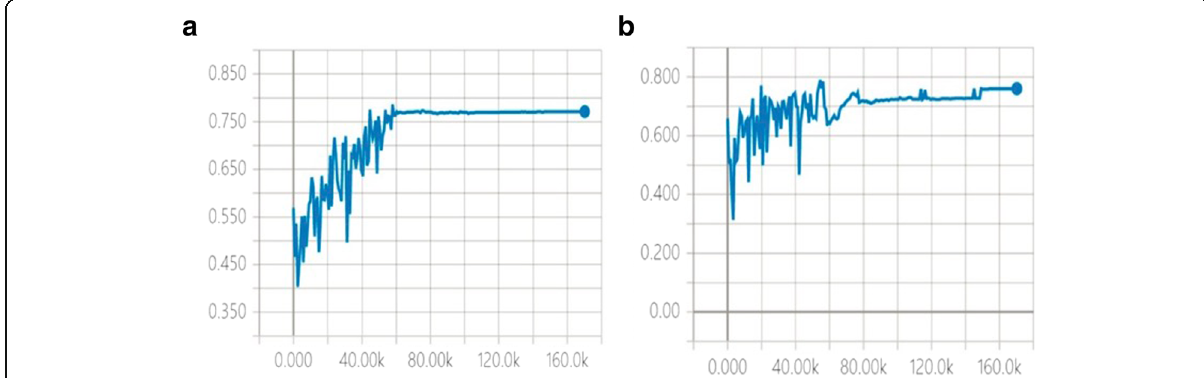
Fig. 4 VOC2007 test set compares the convergence speed and the stability of training convergence of SENET512 (4 a ) and SSD512 (4 b )